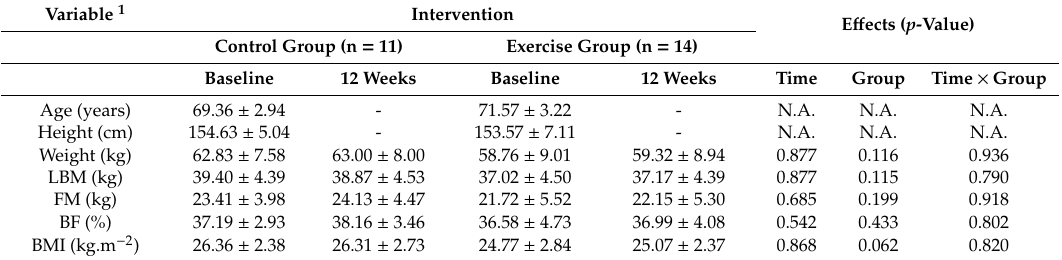
Table 2. Demographic characteristics at baseline and 12 weeks in the control and exercise groups. Variable